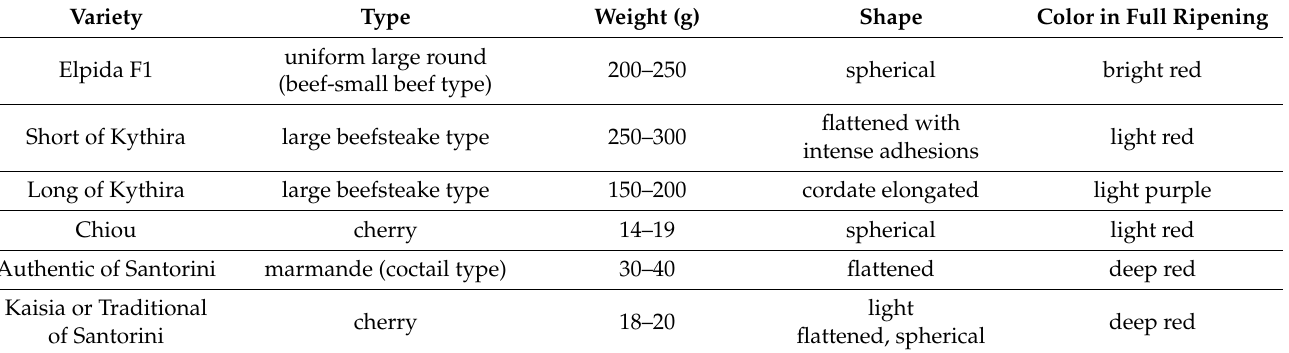
Table 1. Description of tomato fruit used for